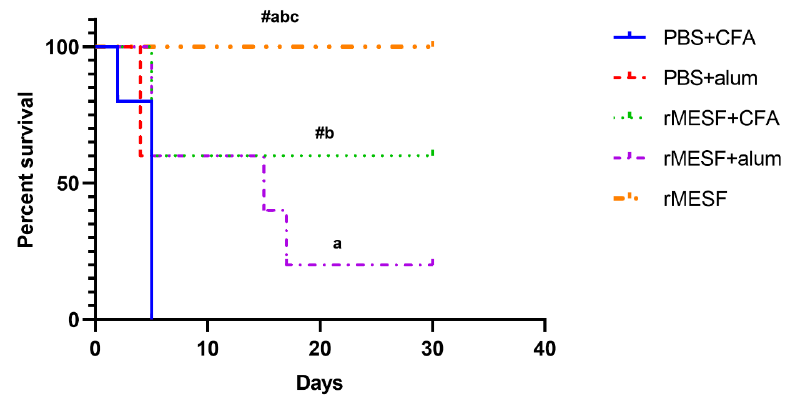
Figure 7. Protective efficacy of rMESF multiepitope fusion protein immunization on survival. Groups of female BALB/c mice (n = 5 mice/group) were immunized through different routes and adjuvant with 25 µ g / mouse of rMESF. Thirty days after the last booster, mice were challenged with a S. flexneri lethal dose of 1 × 10 7 CFU / mouse i.n. Mortality was observed for 30 days. Symbols and letters indicate statistically significant values of p < 0.0001 compared with the respective mice group. # vs. PBS + CFA, a vs. PBS + alum b vs. rMESF + alum, c vs. rMESF + CFA. PBS, phosphate-bu ff ered saline. CFA, complete Freund’s adjuvant. i.n., intranasally. The protective e ff ect was represented as Kaplan-Meier survival